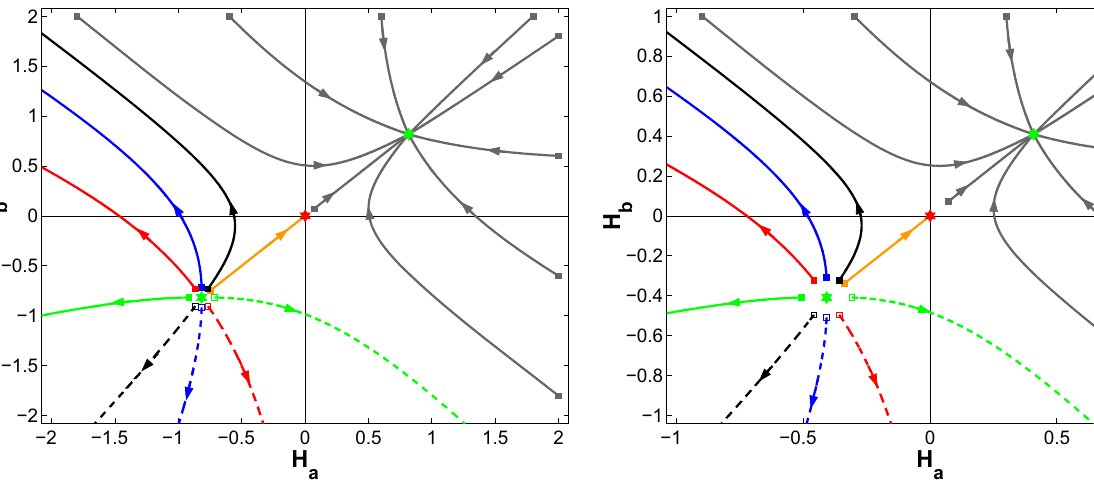
(cid:7) ± ( 0 . 1 ) 2 − ( H ( 0 ) − H ) 2 + H ( 0 ) = (left) and N = 3, √ a dS dS , 2 for the orange square H a 12 H b ( 0 ) = H dS + 0 . 1 / 2, where H dS < 0. 3 in the left plot for gray squares. a H a ( 0 ) equaling values from − 1 . 8 to 1 . 8 with step 1 . 2 and H b ( 0 ) = 2, b H a ( 0 ) = 2 and H b ( 0 ) equaling values from − 1 . 8 to 1 . 8 with step 1 . 2, 4 in the right graph for gray squares a H a ( 0 ) equaling values from − 0 . 9 to 0 . 9 with step 0 . 6 and H b ( 0 ) = 1, b H a ( 0 ) = 1 and